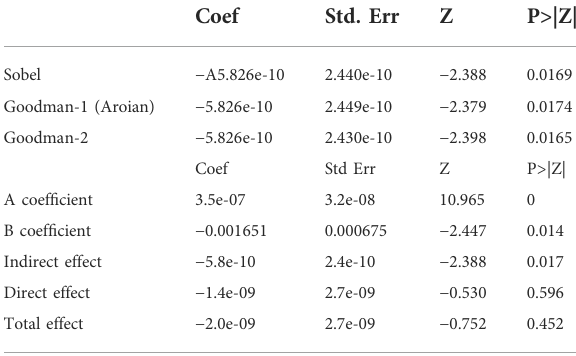
TABLE 4 Sobel-goodman mediation